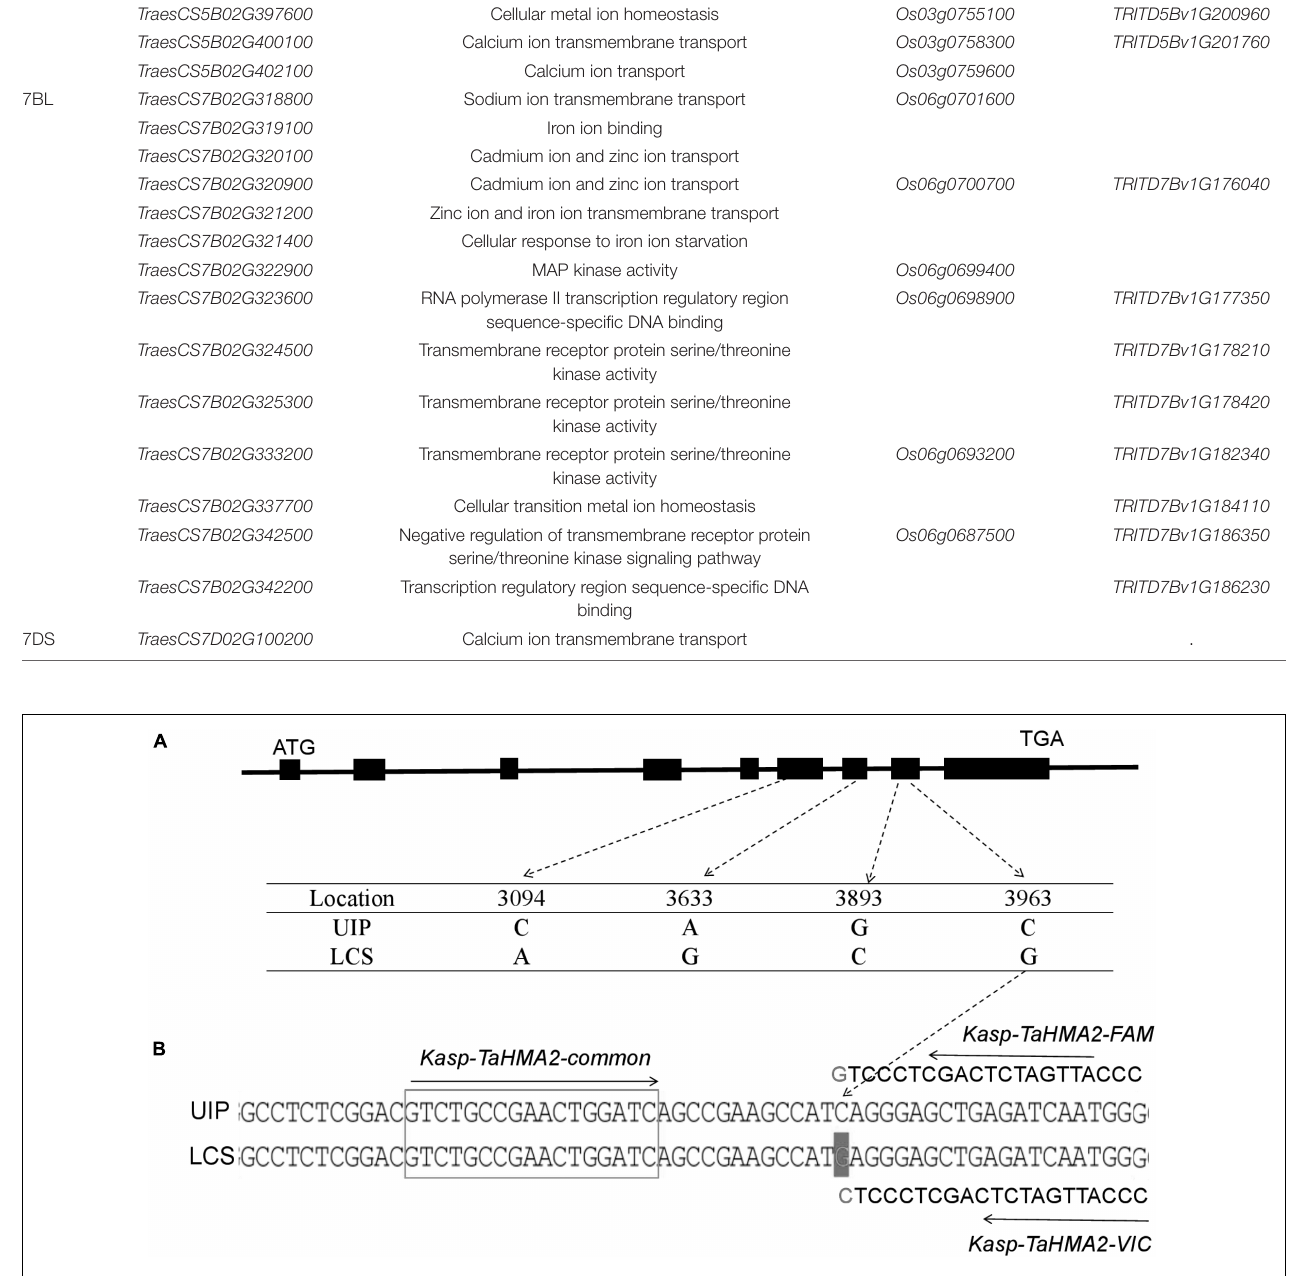
Frontiers in Plant Science |